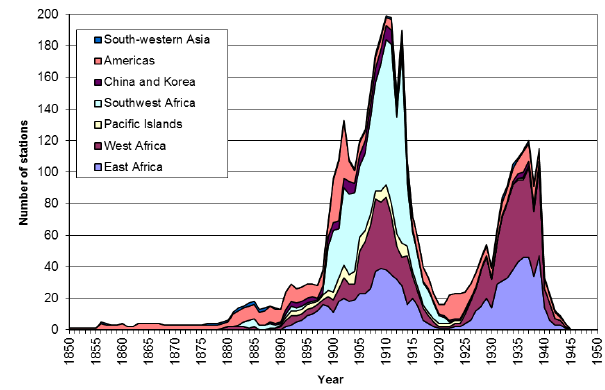
Figure 8. Number of overseas stations of German Naval Observa- tory Hamburg in specific world regions.